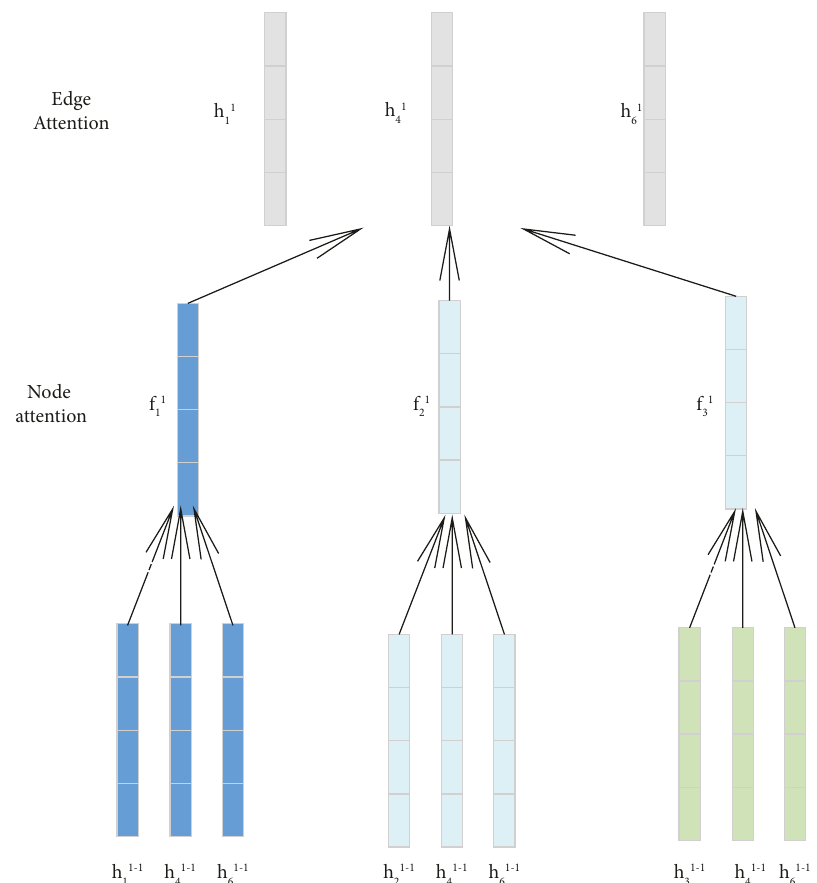
Figure 3: The overall architecture of Graph Attention Network information